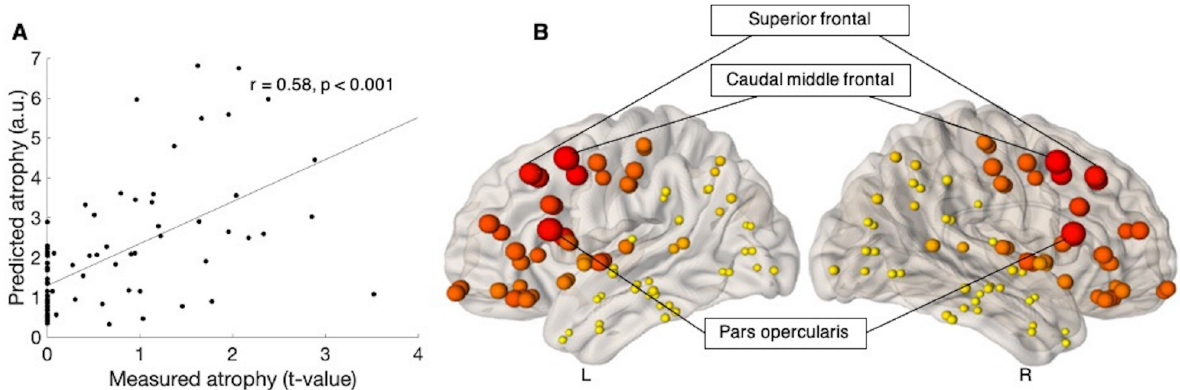
Fig 5. Prediction of atrophy pattern at twelve-month follow-up. (A) Scatter plot of the correlation between predicated and measured atrophy, when measured atrophy was estimated between ALS patients at twelve-month follow-up and ALS patients at six-month follow-up. Pearson’s correlation coefficient (r) and the significance of the correlation (p) are shown, p is family-wise error (FWE) corrected. (B) Visual representation of maximum correlation obtained for each node, when measured atrophy was estimated between ALS patients at twelve-month follow-up and ALS patients at six-month follow-up. The size of the ball corresponds to the maximum correlation between predicted and measured atrophy. The colour of the balls ranges from light yellow (for smallest) to dark red (for biggest). L is left and R is Right. a.u. is arbitrary unit.